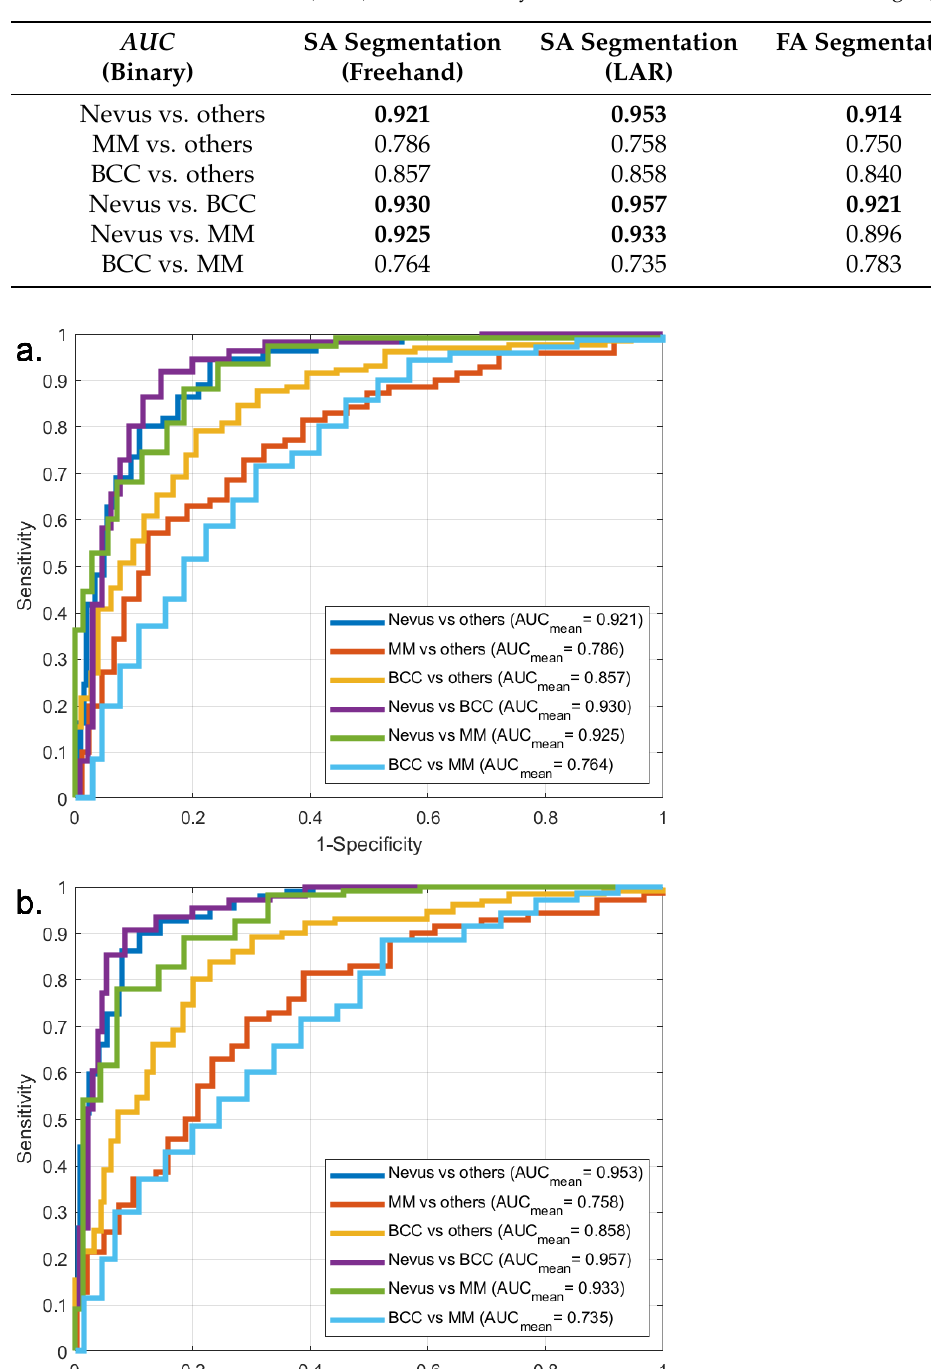
Table 3. Area under the curve ( AUC ) values of binary classification. Values over 90% are highlighted.